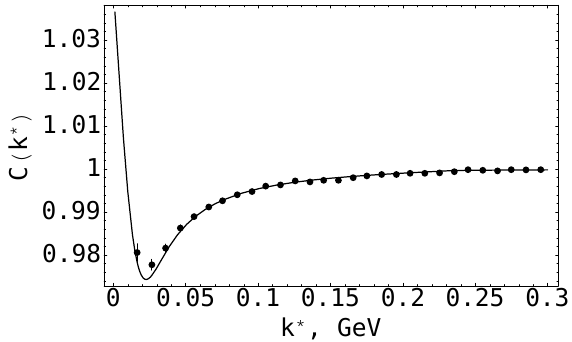
Figure 3. The K 0 K + correlation C ( k ∗ ), see Ref. [8] and references therein. Solid line represents our fit, S points are experimental data